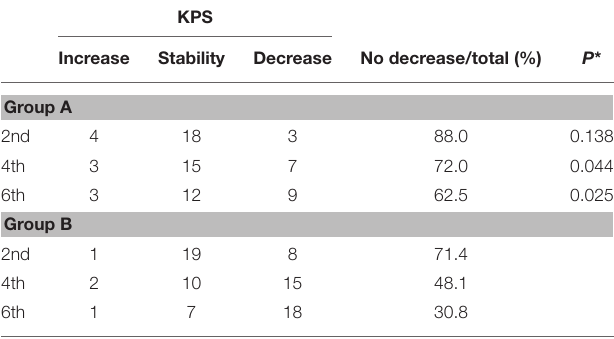
TABLE 3 | The quality of life of patient in two groups.